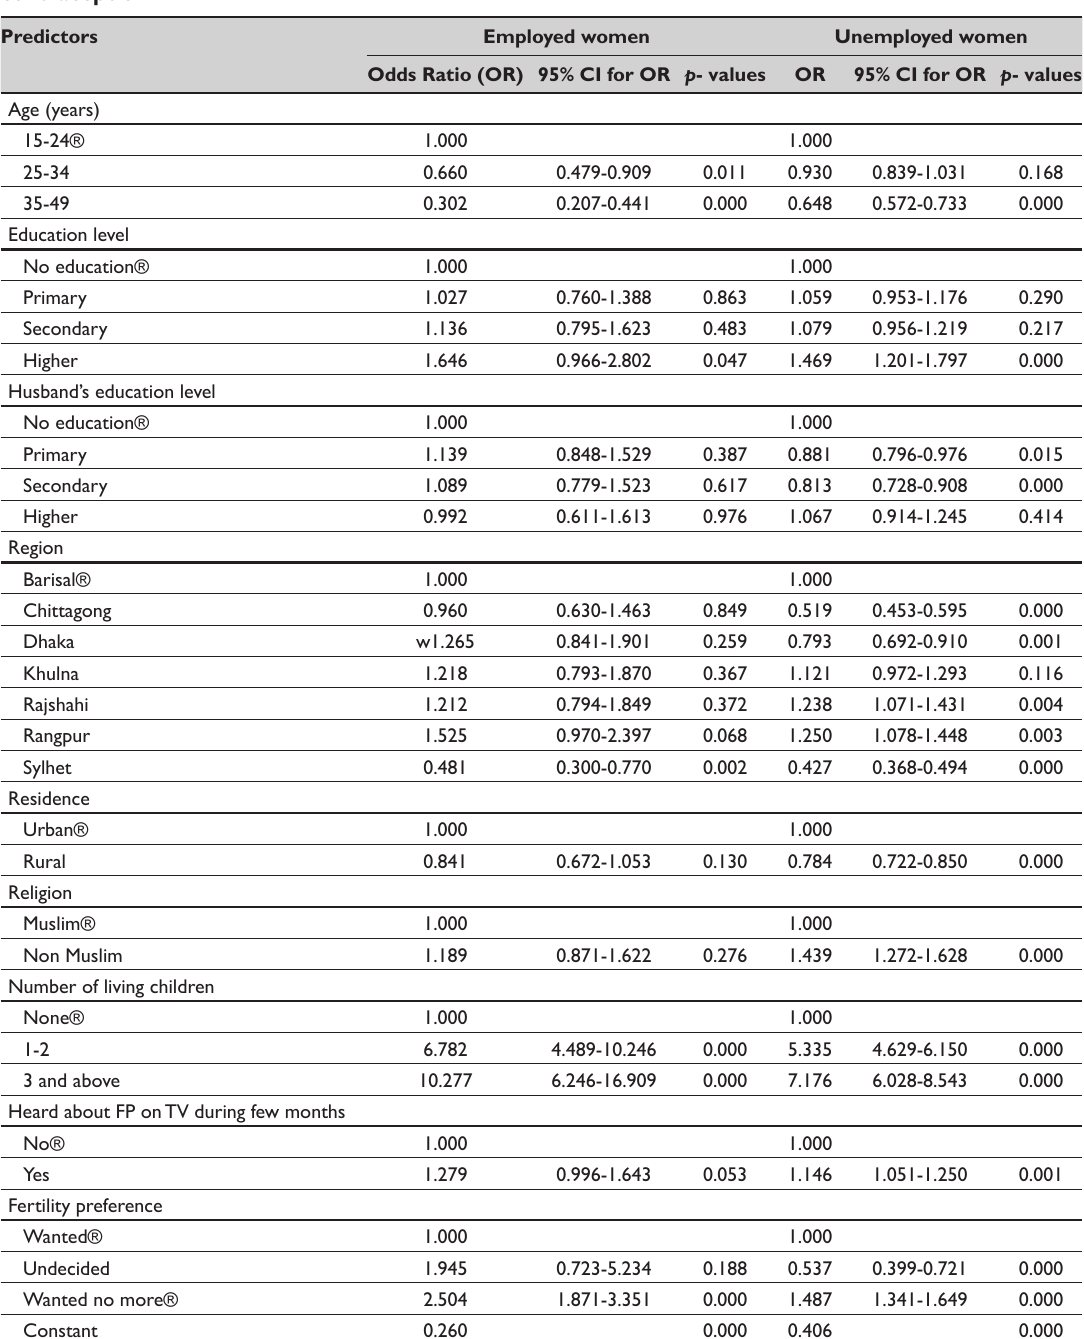
Table 4: The odds ratio of logistic regression models for the determinants of current use of contraception